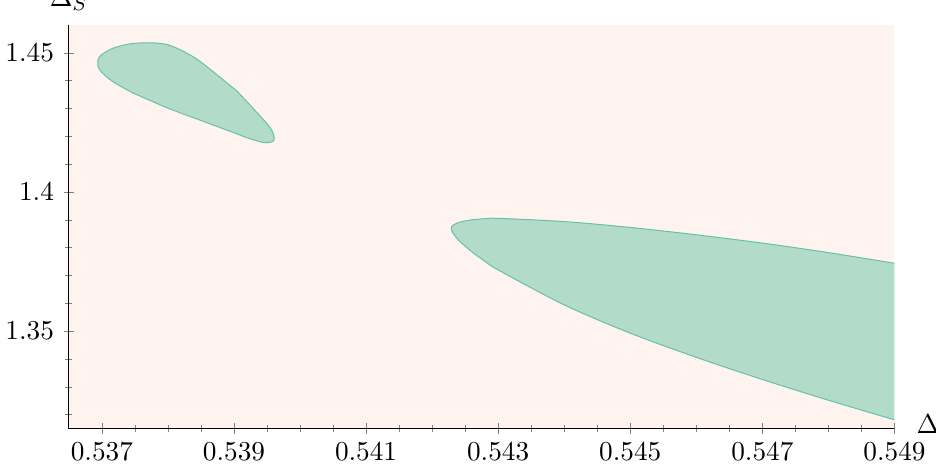
Figure 11: Allowed region (in green) for the O